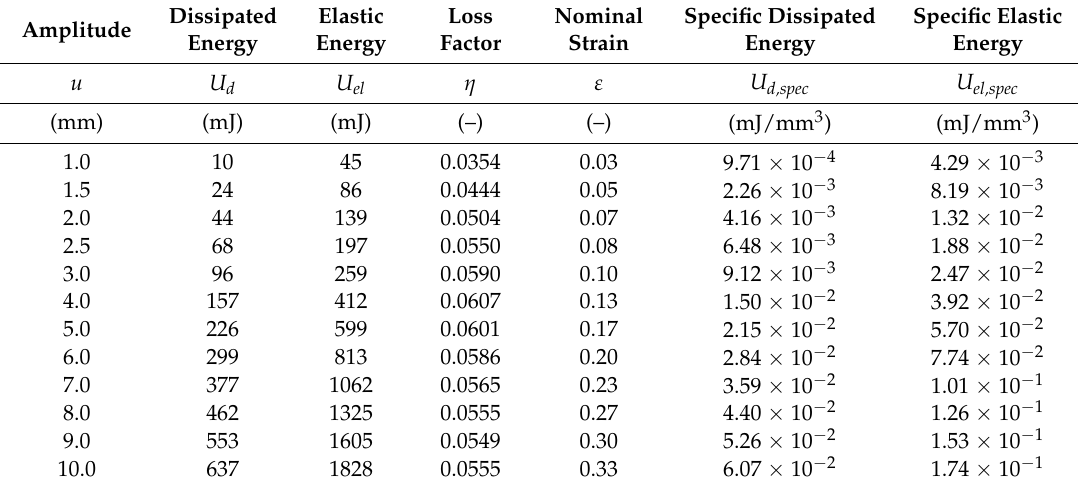
Table 1. Material damping properties obtained from ramped cyclic T-joint test.